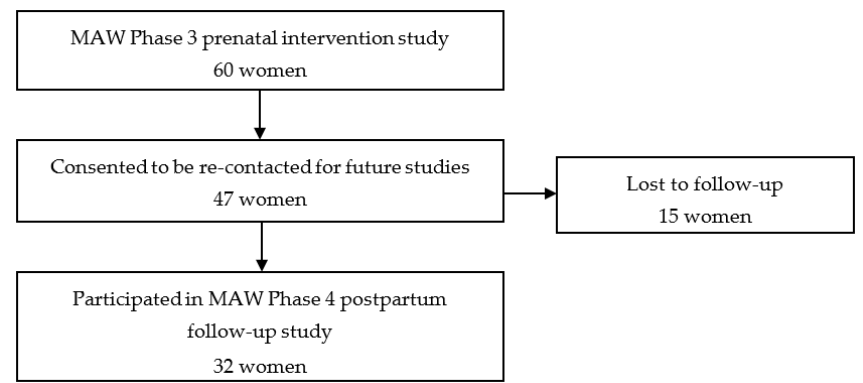
Figure 1. Participant flow.